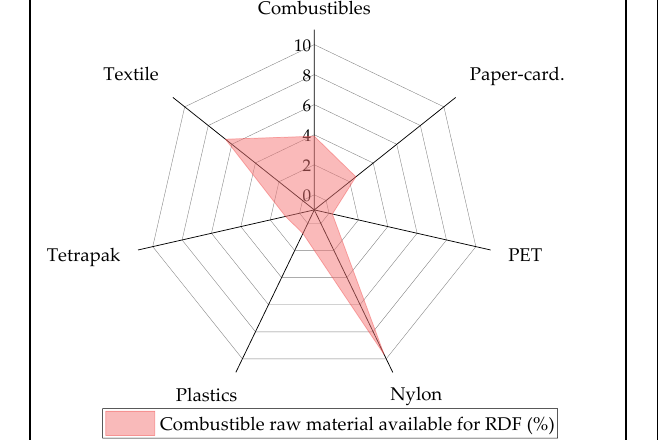
Figure 13. Detail of composting in Lahore: ( a ) Municipal waste processed and compost produced; ( b ) GHG emission from compost and incineration (RDF).